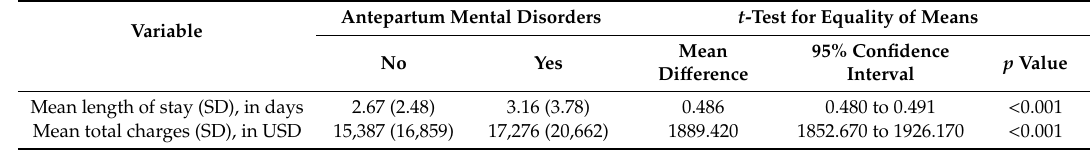
Table 3. Di ff erence in length of stay and charges due to antepartum mental disorders.